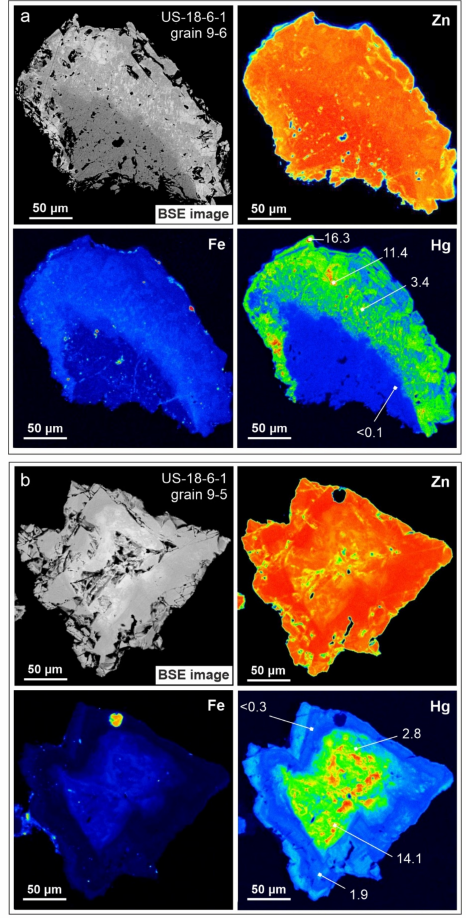
Figure 13. Back-scattered electron (BSE) images and element maps (Zn, Fe, Hg) of irregular ( a ) and zonal ( b ) distribution of Hg in South Sakhalin MV sphalerite. The numbers show Hg contents in wt% (WDS-EDS data). For representative compositions of the grains see Tables 4 and